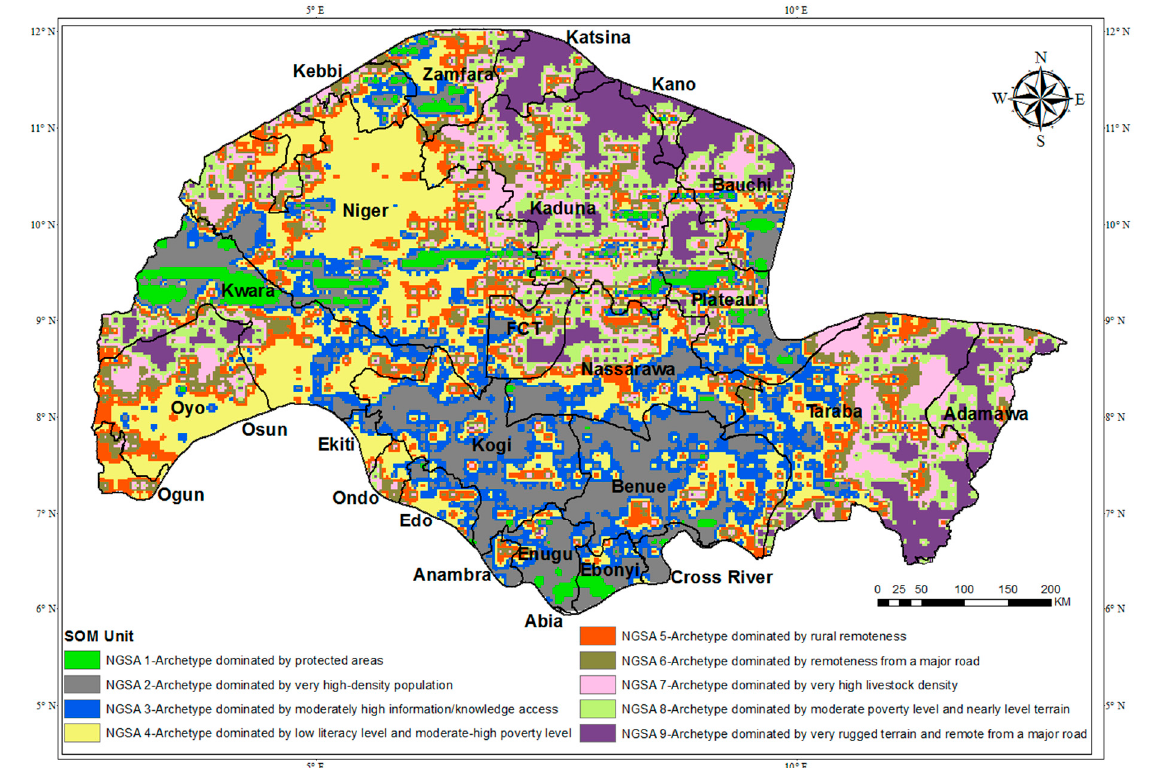
Figure 6. Spatial characterization of archetypes of LD drivers. See supplementary material, Section 6 for the full description and ranking of the archetypes in relation to administrative and land status. Table 2. Description and share of the archetypes of LD